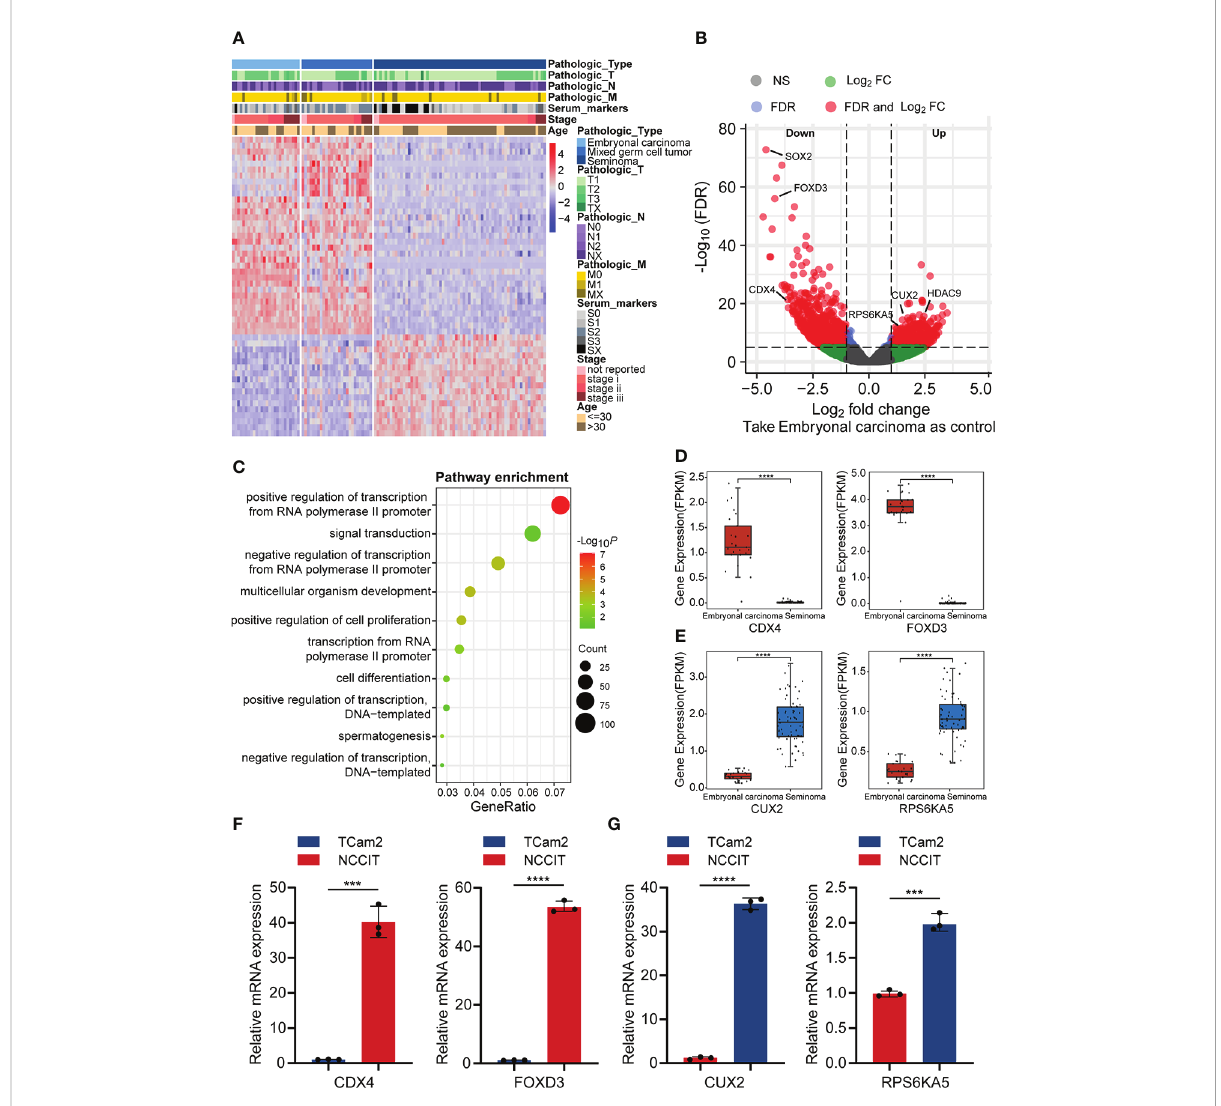
FIGURE 1 The difference in gene expression between TGCT subtypes. (A) Heatmap showed the difference in expression of the top 1000 genes between embryonal carcinoma, mixed germ cell tumor and seminoma analyzed by ANOVA (FDR<0.05). (B) The volcano plot demonstrated the differentially expressed genes between embryonal carcinoma and seminoma analyzed by R package “ limma ” (FDR<0.05, logFC>1). Up: Up- regulated differential genes in seminoma compared with embryonal carcinoma; Down: Down-regulated differential genes in seminoma compared with embryonal carcinoma. (C) The bubble chart indicated the GO enrichment of the differential genes between embryonal carcinoma and seminoma. (D, E) The boxplot revealed the expression of the two groups of differential genes (data from TCGA). (F, G) Expression of the above genes was veri fi ed by qPCR in the TGCT cell lines. ANOVA: one-way analysis of variance. **** P < 1e-04, *** P <